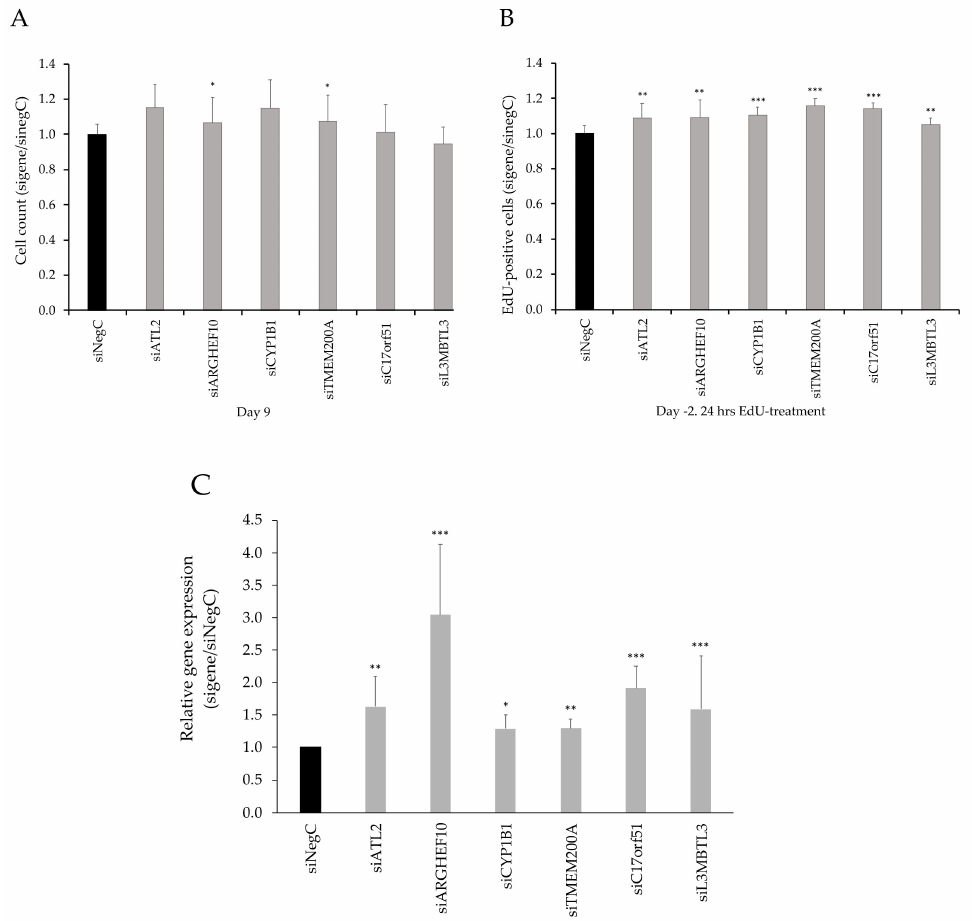
Figure 4. ( A ) Cell number at day 9 of di ff erentiation was measured by Hoechst staining of nuclei. ( B ) Cell proliferation was evaluated by measuring DNA-synthesis with 5-ethynyl-2 (cid:48) -deoxyuridine (EdU). ( C ) mRNA-levels of proliferation marker mKI67 were measured with real-time qPCR at day 0 before di ff erentiation was initiated. Results were analyzed using a t -test and presented in fold change ± SD relative to negative control of a corresponding time point (Neg C). *** p < 0.005, ** p < 0.01, * p <